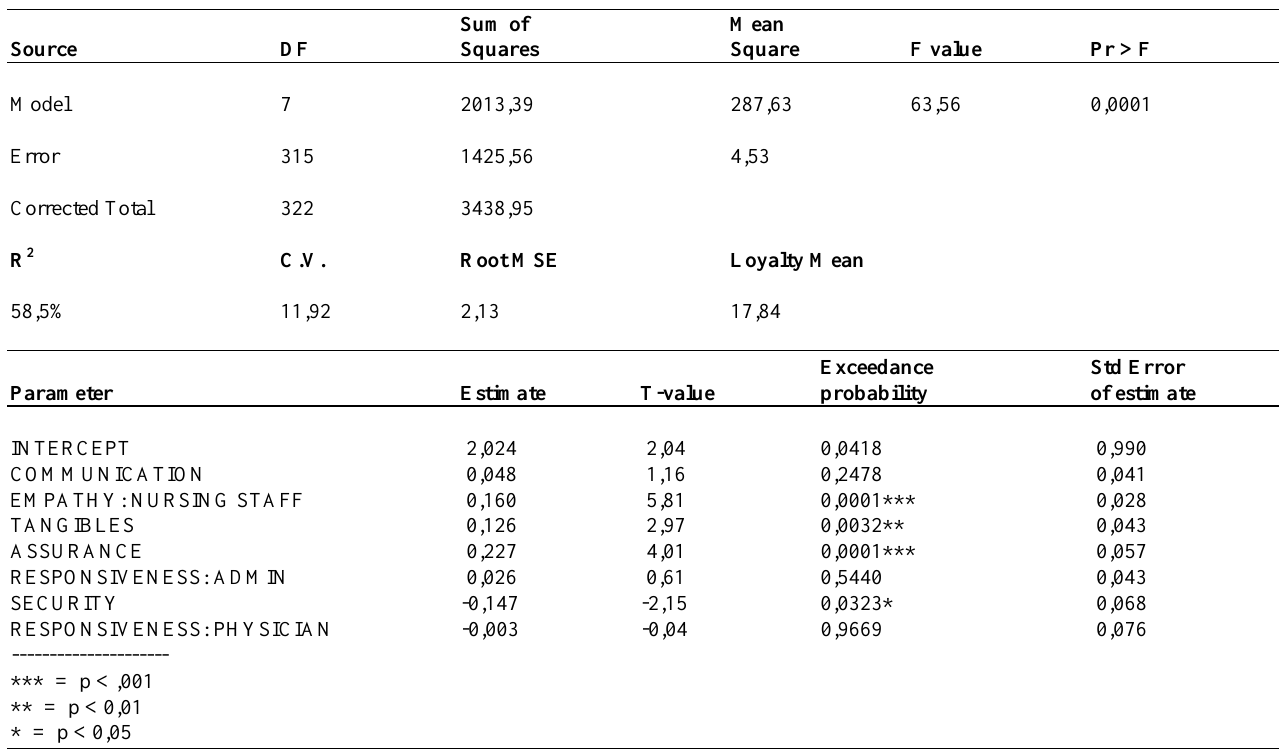
Table 3: Multiple regression results: Impact of service quality dimensions on loyalty Dependent Variable: LOYALTY (Buying intentions or willingness to re-purchase)